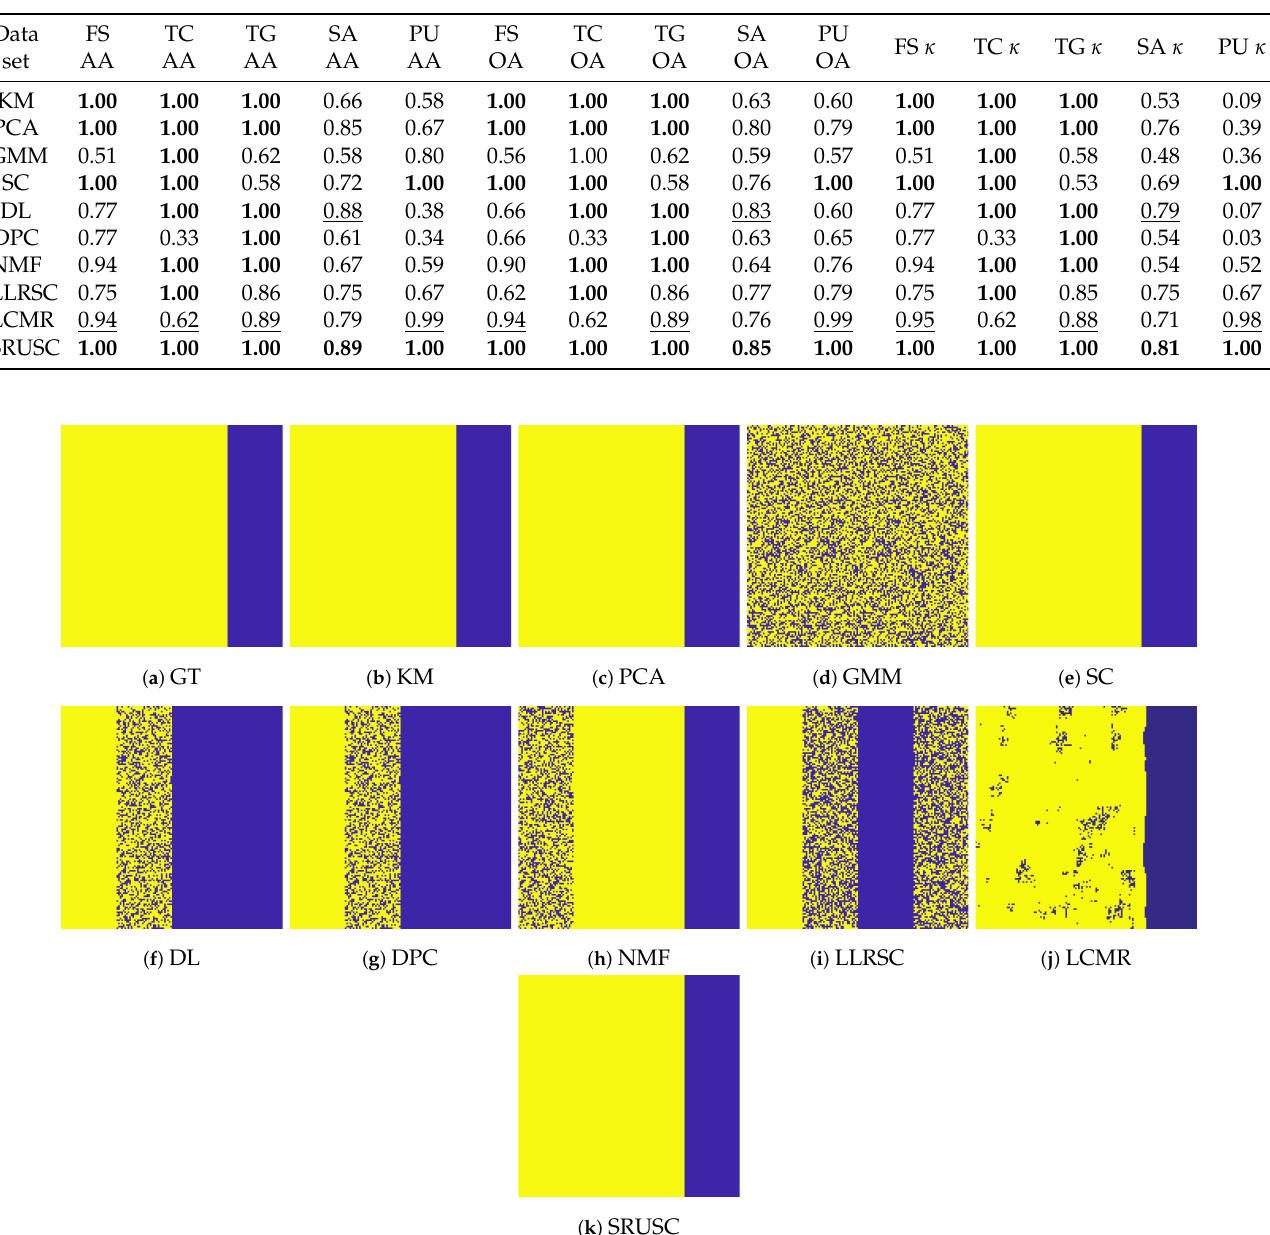
Table 1. Results for clustering experiments. We see that across all methods and data sets, the proposed SRUSC method gives the best clustering performance.